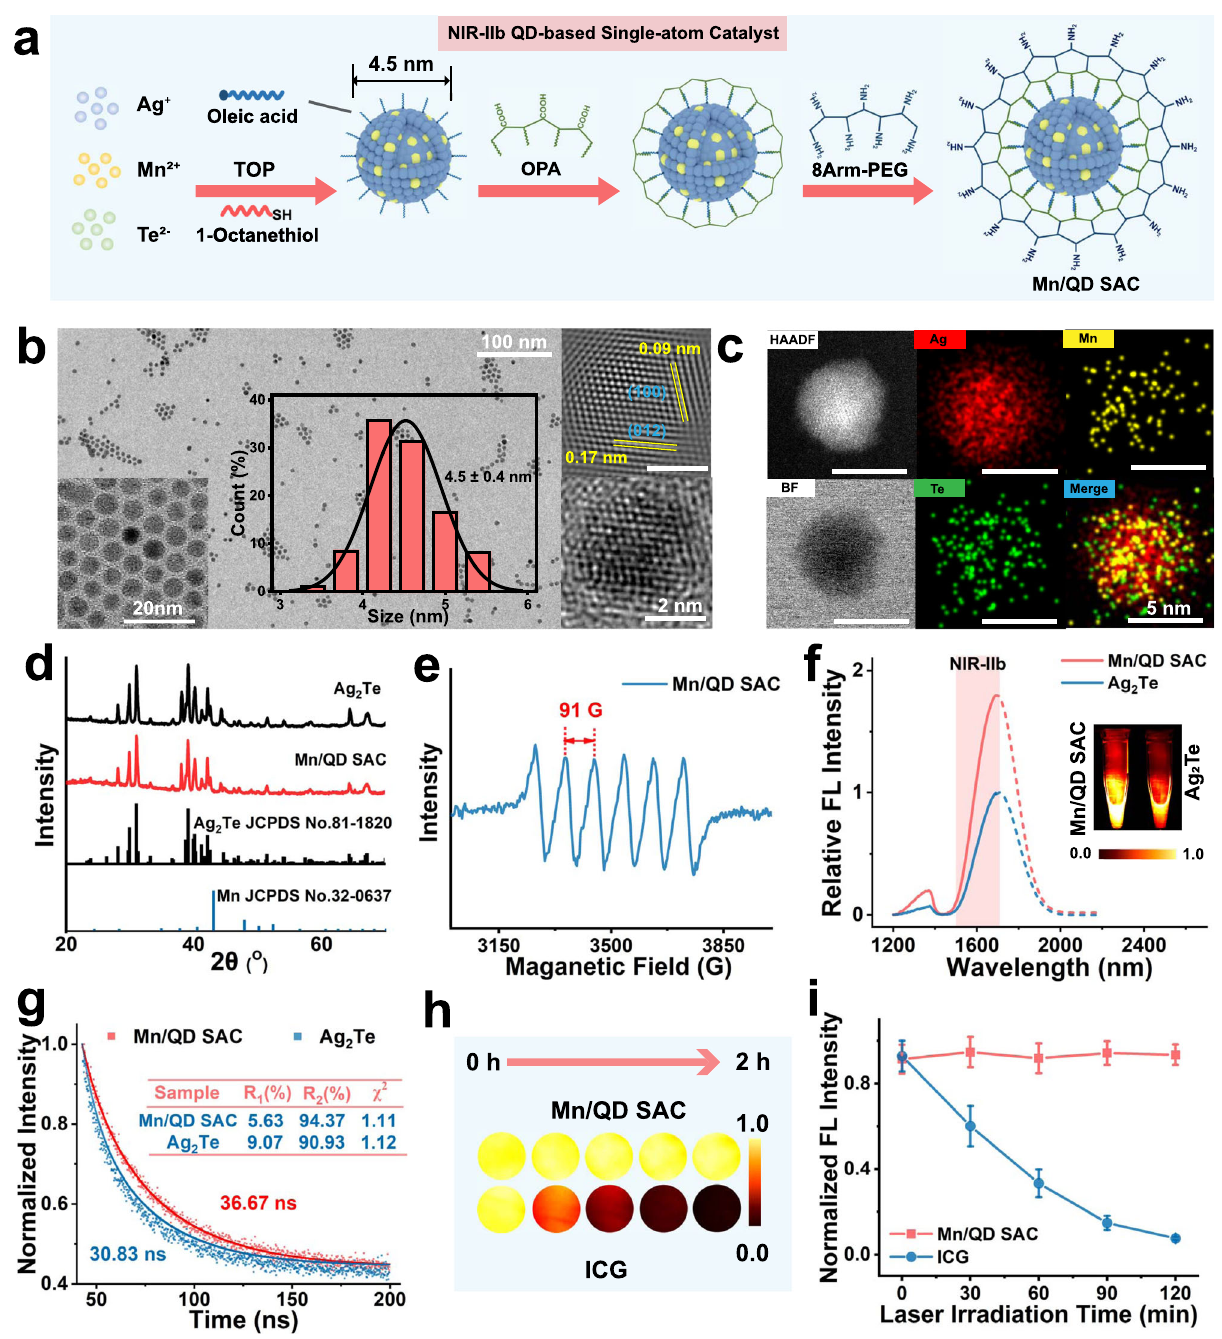
Fig. 2 | Preparation of NIR-IIb QD-based single-atom catalyst with antioxidant activity and fl uorescence properties. a Schematic diagram of synthesis and construction of Mn/QD SAC. b The TEM image, high-resolution HAADF-STEM image, and size distribution statistics of Mn/QD SAC. Data are presented as means±SD( n =300particles). c HAADF-STEMimagesandenergy-dispersiveX-ray spectroscopy (EDS) mapping of Mn/QD SAC. d XRD patterns of Mn/QD SAC and Ag 2 Te QDs. e The ESR pattern of Mn/QD SAC. f Fluorescence emission spectra of Mn/QD SAC and Ag 2 Te QDs. The inset images were the NIR-IIb images of Mn/QD